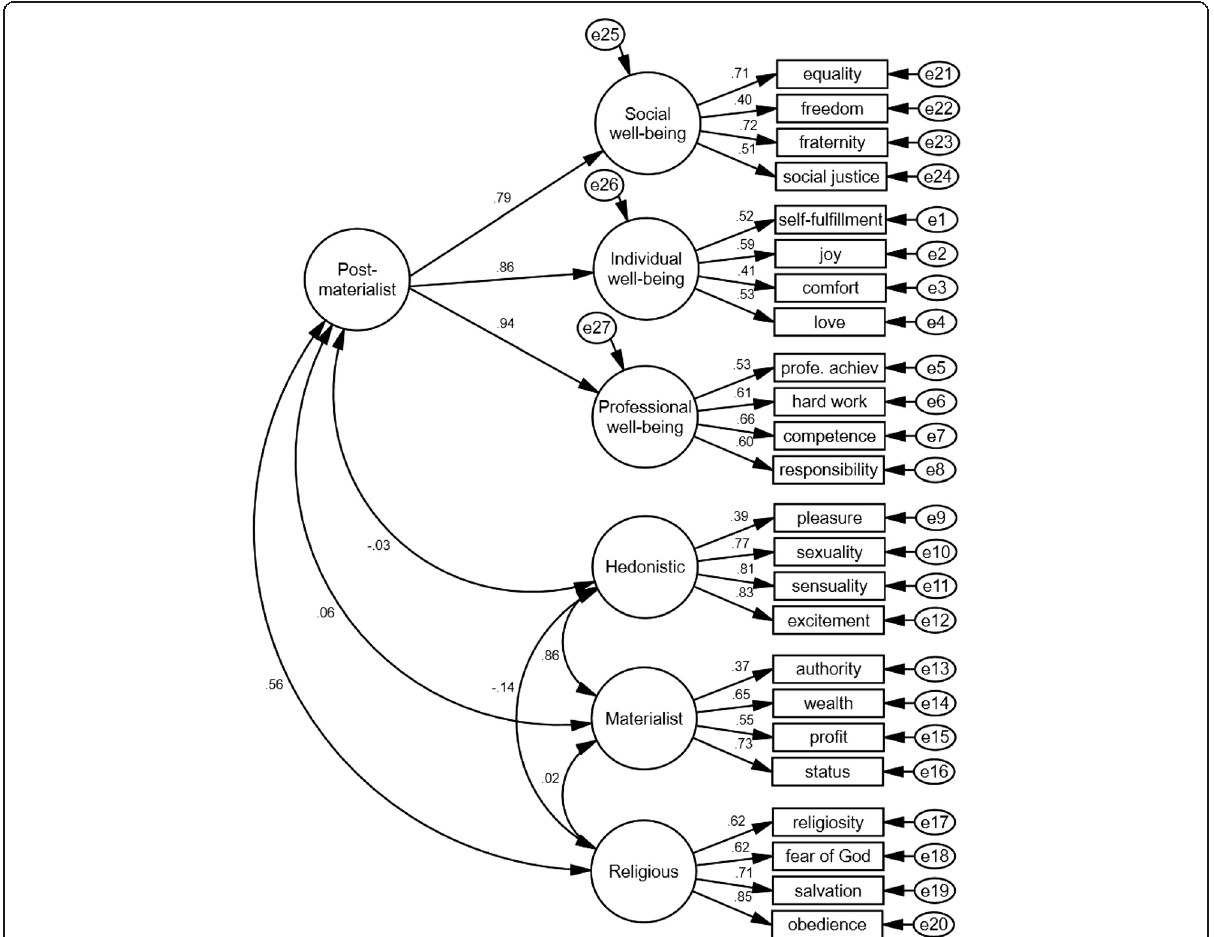
Fig. 1 Factor structure of the Psychosocial Values Questionnaire